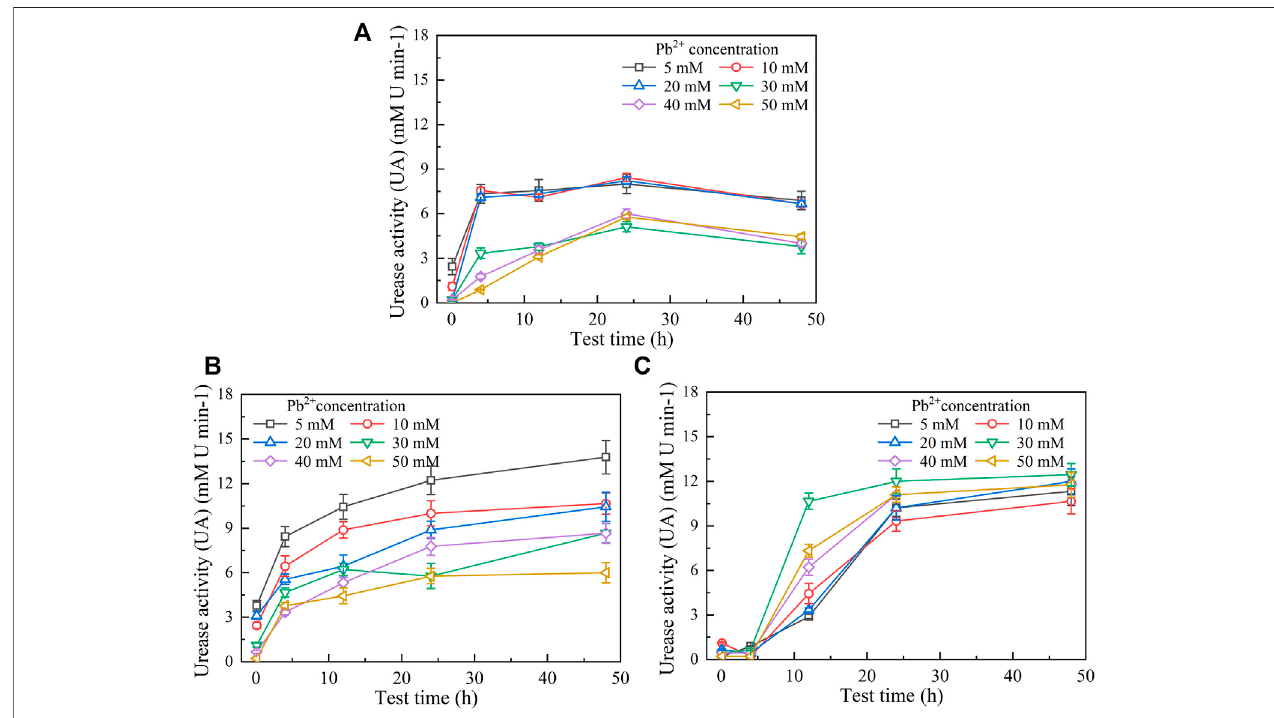
FIGURE 1 | Temporal relationships of urease activity (UA) against Pb(NO 3 ) 2 concentrations: (A) without yeast extract and CaCl 2 addition, (B) under the effect of yeast extract, and (C) under the effect of yeast extract and CaCl 2